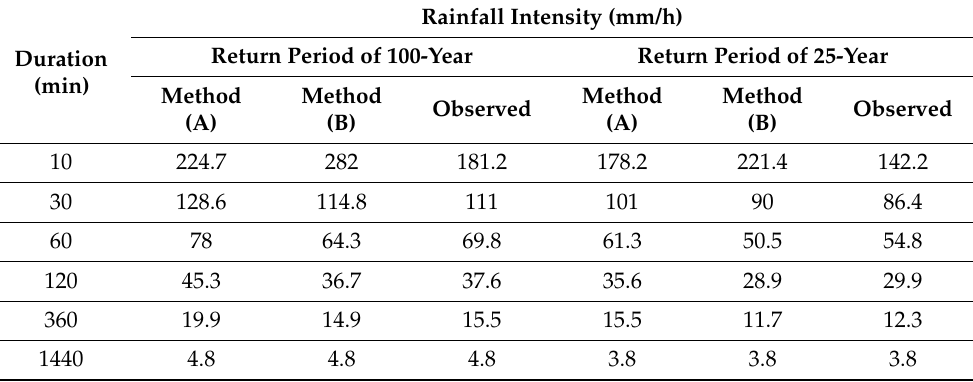
Table 5. The rainfall intensity of 100- and 25-year return periods using Gumbel distribution.